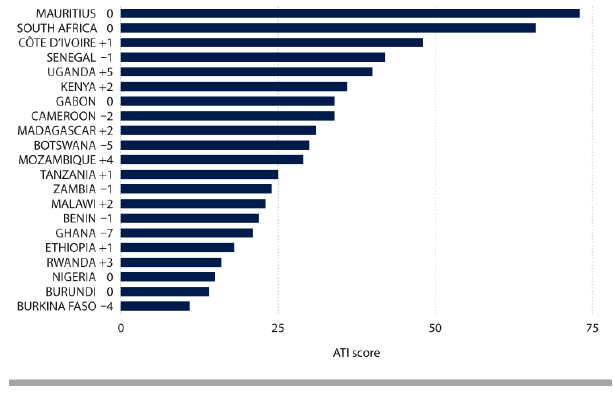
Fig. 3. Ranking of African countries based on the African Transformation Index (ATI). The ATI is a composite number based on indicators for a large number of sectoral categories. Shown is the average score for 2009 and 2011. Numbers after country names indicate the change in rank between 2000 and 2010. Source: African Centre for Economic Transformation